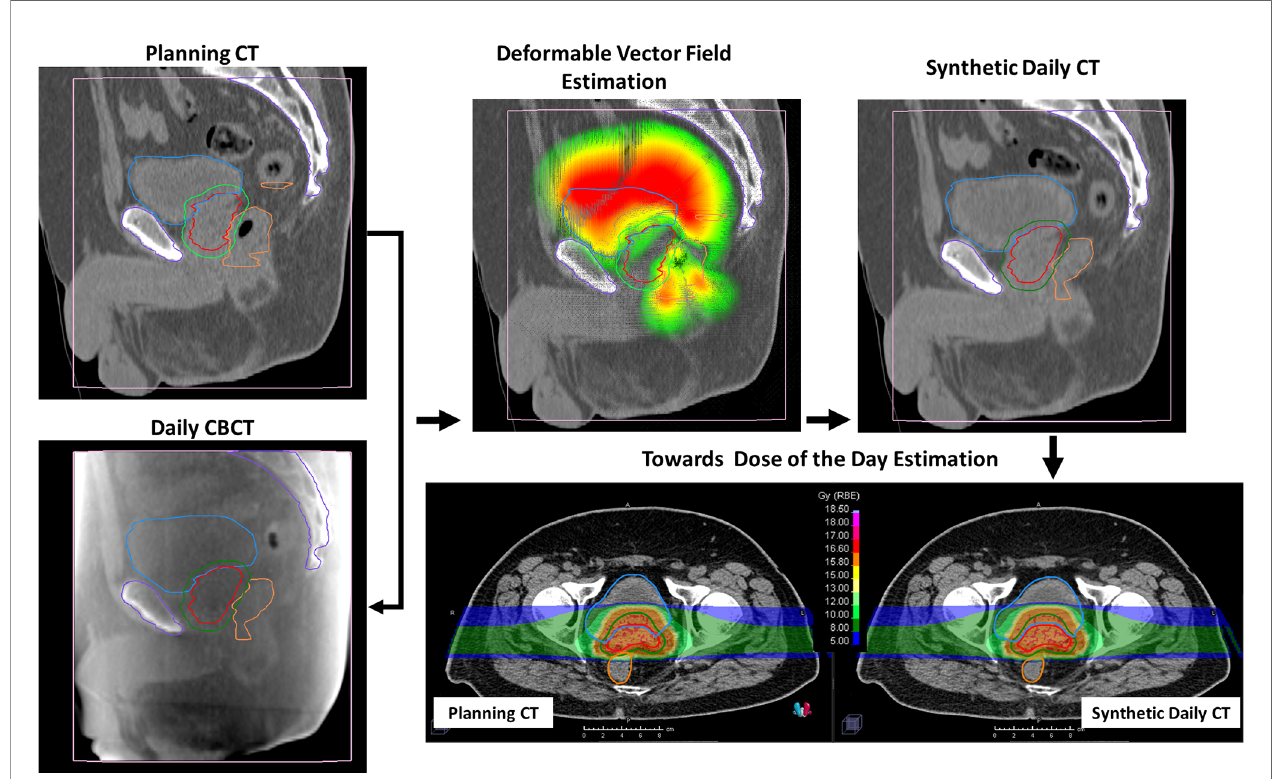
FIGURE 1 | Representative example of the study work fl ow. Bladder (blue), rectum (orange), clinical target volume (CTV) (red), and planning target volume (PTV) (green) were contoured both on planning computed tomography (pCT) and on cone beam computed tomography (CBCT). Bony anatomy (violet) was delineated in pCT and rigidly propagated on CBCTs. The deformation vector fi eld was estimated considering the delineated structures as “ controlling ROIs, ” focusing on the CBCT fi eld of view. The planned dose distribution was then recalculated on the resulting synthetic CT